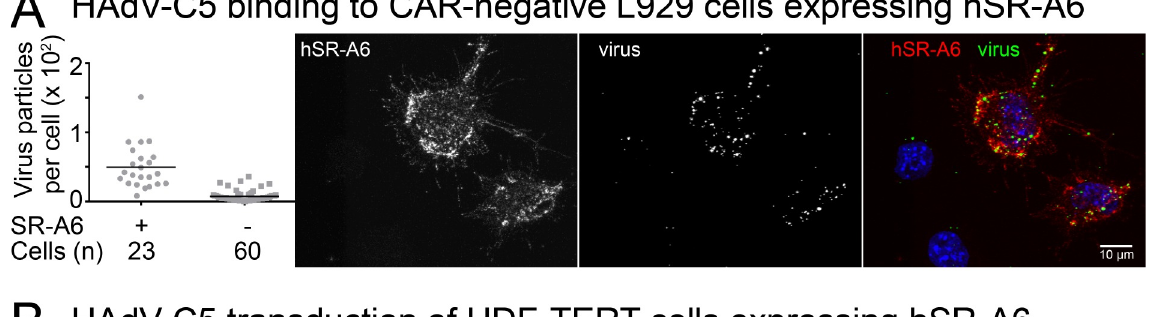
PLOS Pathogens| https://doi.org/10.1371/journal.ppat.1006914 March 9, 2018 15 /